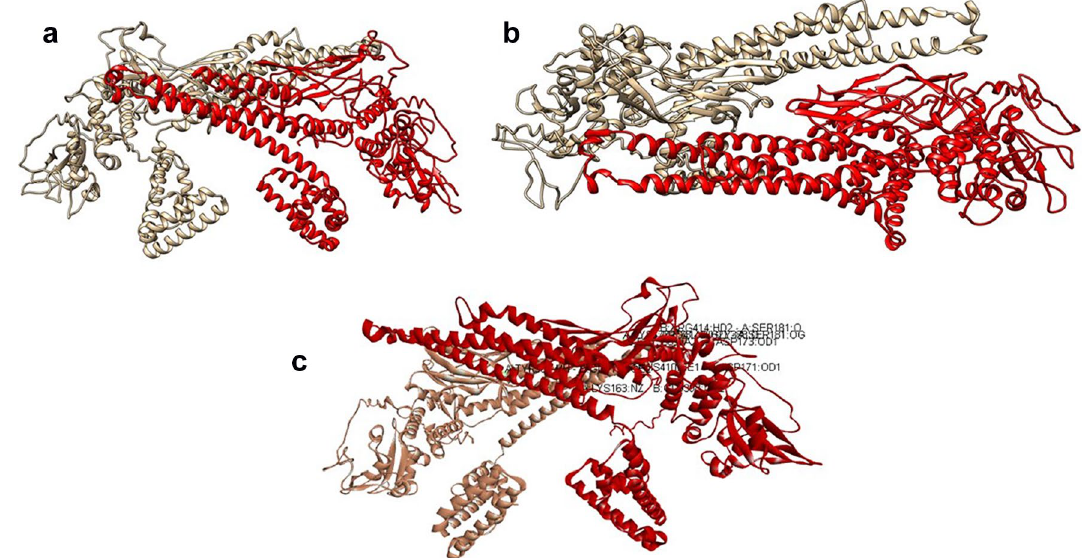
Figure 5. Dimeric structure of STAT3α (one monomer is in gold colour and the other monomer is in red colour) generated by Chimera MatchMaker using dimeric STAT1 (PDB ID 1YVL) as a template. ( a ) Side view, NTDs and DBDs face each other, ( b ) Top view, coiled coil domains in an antiparallel arrangement. ( c ) Hydrogen bond and electrostatic interactions between monomers at one end of STAT3α dimer identified using BIOVIA Discovery